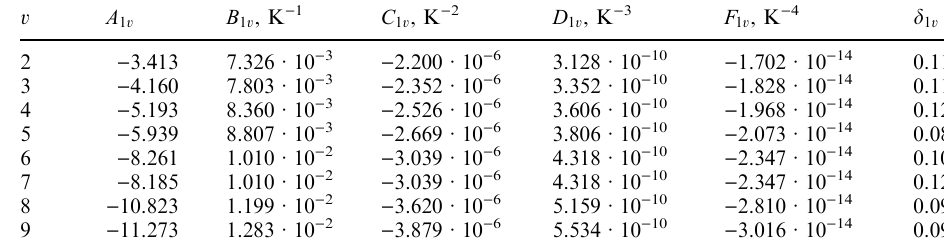
Table 3. Coe(cid:129)cients for calcu- lations of Q 1 v for 1500 (cid:20) T e (cid:20) 6000